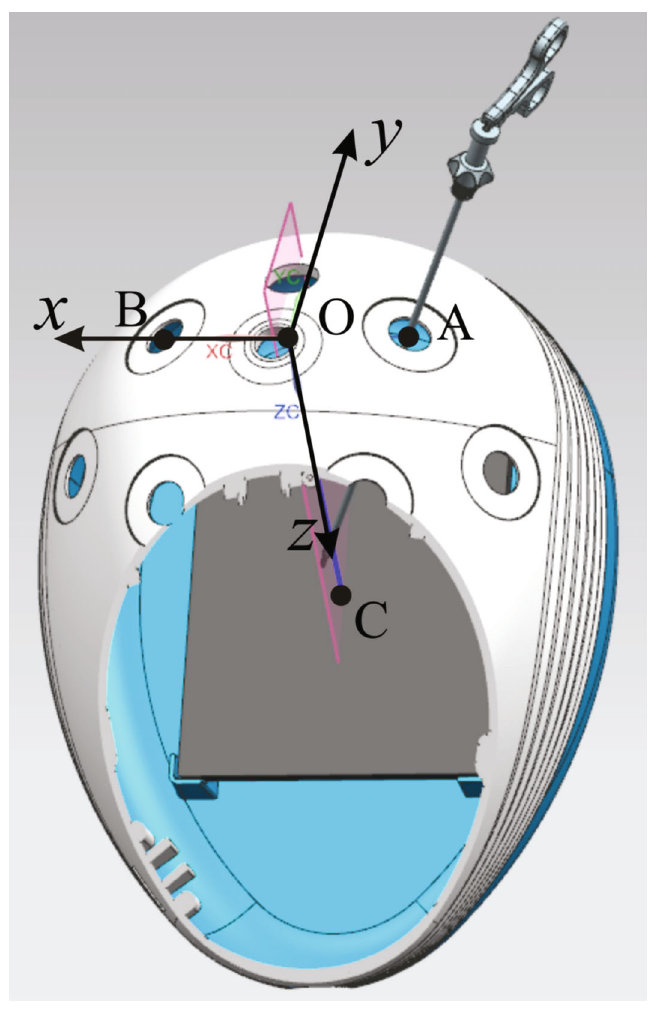
Figure 5: Coordinate system on the